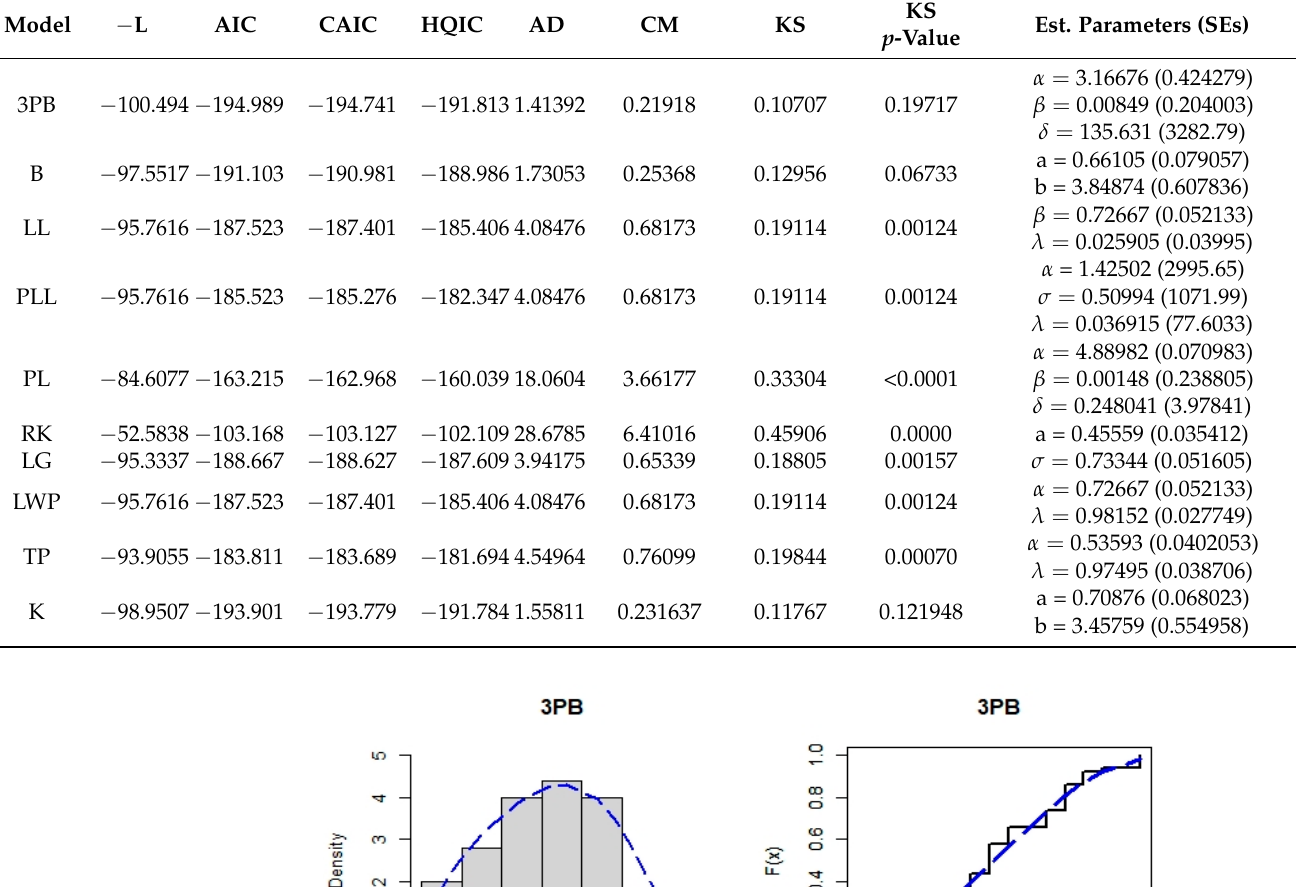
Table 5. Numerical information criteria values with the goodness-of-fit measures for the stress- rupture data set.